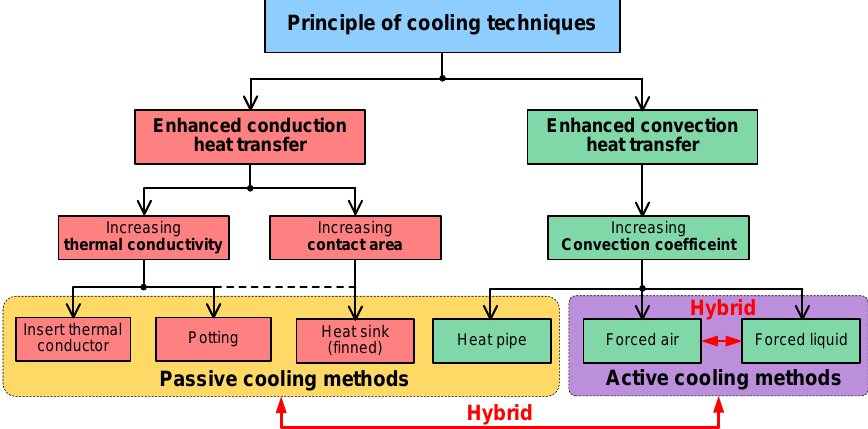
Figure 5. Principles of passive and active cooling techniques for electrical machines.